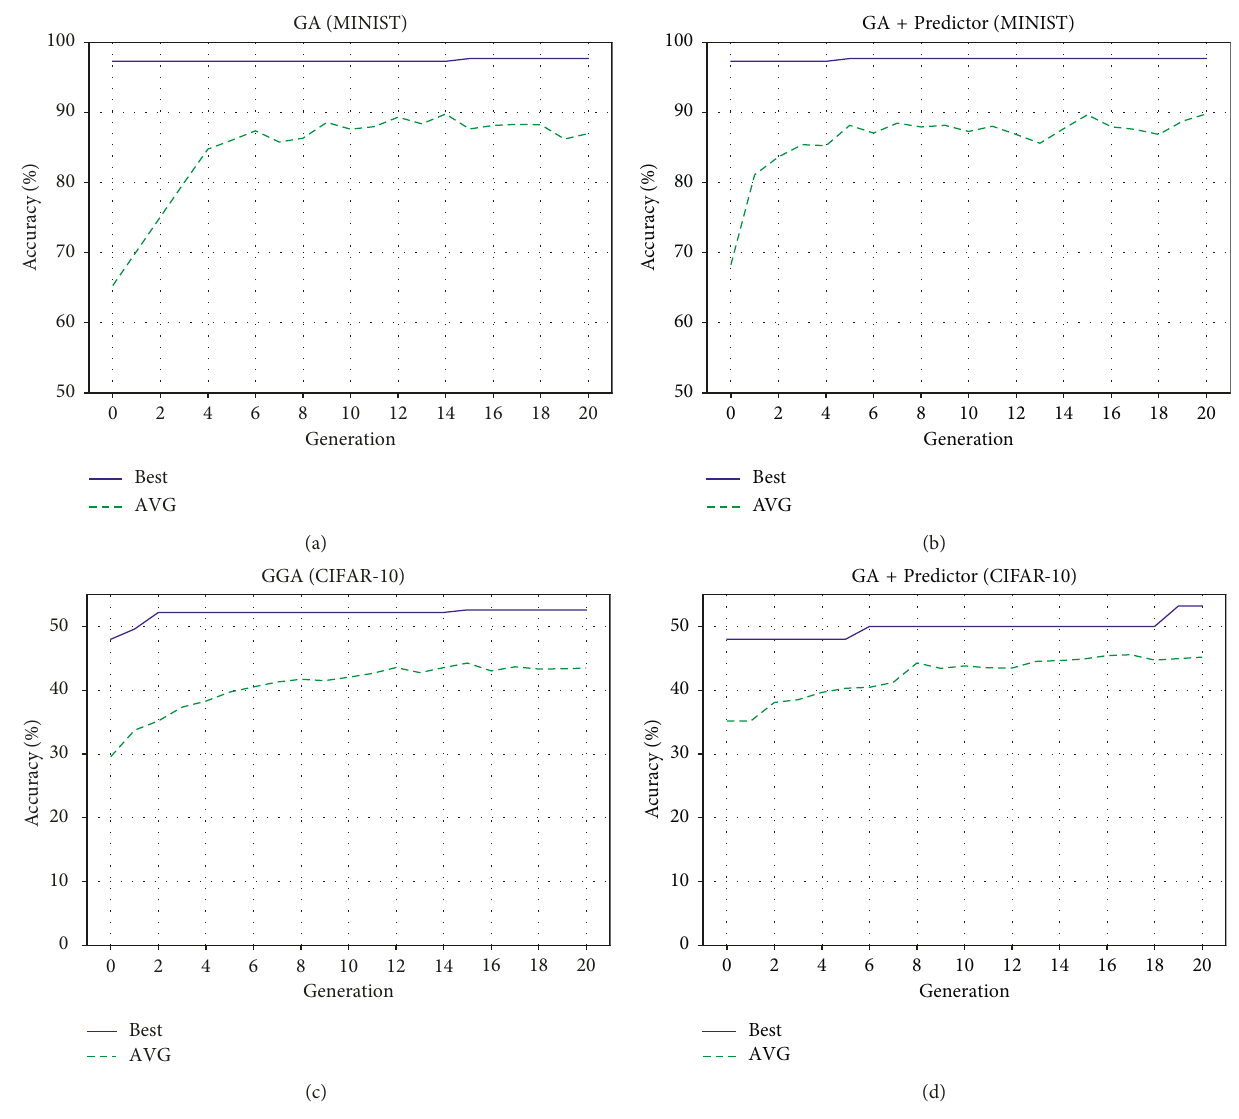
Figure 9: Population evolution for the MNIST and CIFAR-10 datasets.